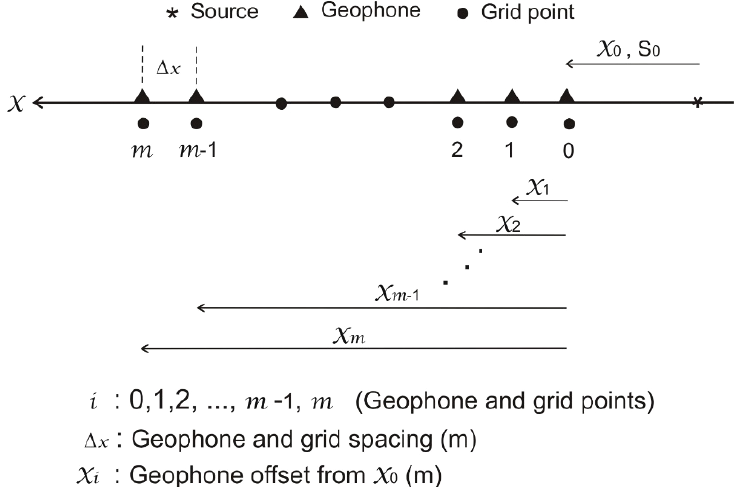
Figure 10. The data processing system designed to convert single-station group velocities at geophone locations into local group velocities at grid points is illustrated